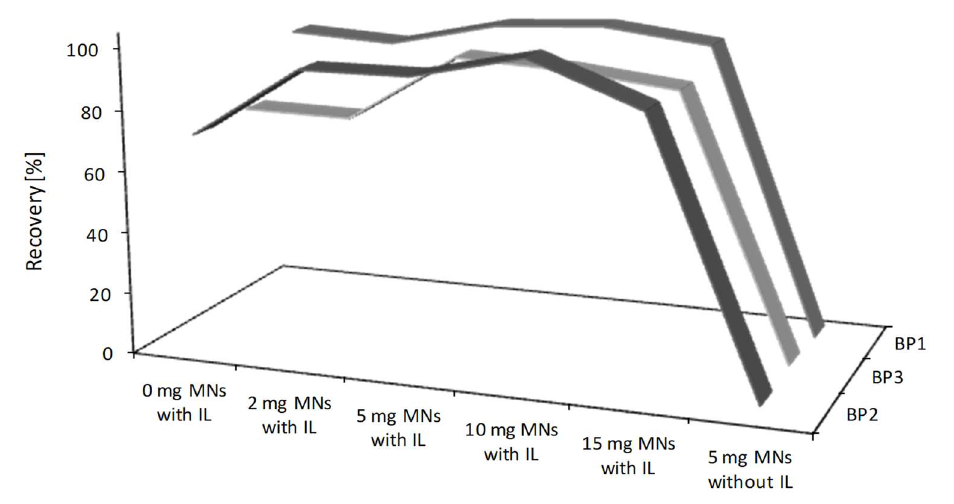
Figure 6. Impact of the amount of Fe 3 O 4 on the recovery of the target analytes. Method parameters: sample volume—10 mL, DDAC concentration—1%, the DDAC to NaClO 4 molar ratio—1:2. Sample without Fe 3 O 4 was centrifuged and then cooled in an ice bath.